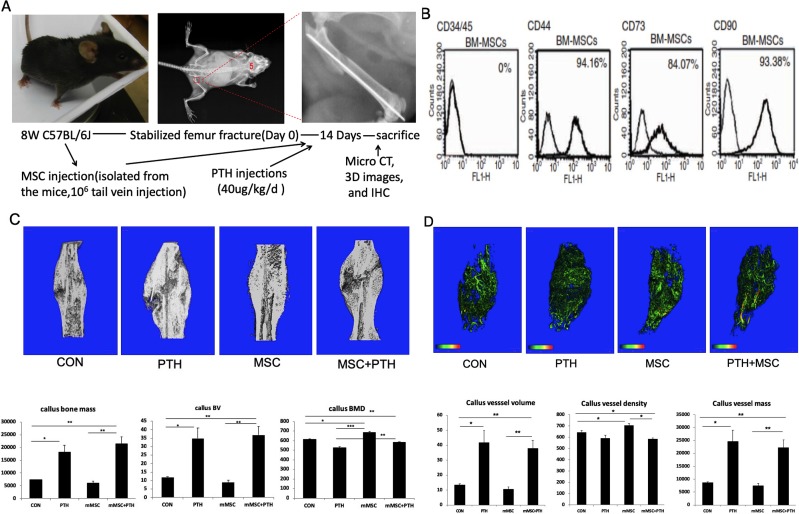
Experimental design and model establishment.(A) Stabilized femur fractures were produced in 6-week-old C57BL/6 female mice. Mice were divided into 4 groups: The control group was treated by subcutaneous injection of the vehicle (BSA) daily; the PTH group was treated with subcutaneous injection of 40 μg/kg/day of PTH (1–34); the PTH+MSC group and the MSC group were treated by injecting BM-MSCs systemically in combination with or without PTH. After 14 days of treatment, bone regeneration and neovascularization were monitored using μCT, and the samples were harvested for micro CT analysis, 3D images capture, and immunohistochemistry analysis. (B) We isolated and obtained an MSC population in which >90% of cells expressed the specific MSC markers CD90 and CD44 and 84.07% of the CD73 marker. Furthermore, after immunodepletion, the MSCs were negative for CD45 (0.9±0.5%). (C) Results from the μCT analysis and quantitative analysis of bone formation in fracture calluses was performed, and the callus bone mass, callus bone volume and callus bone mineral density were calculated. (D) The blood vessels detected by microCT were quantified in decalcified calluses. Data are presented as the mean +/− SEM (n = 12) for the groups. Student’s t test for two groups comparisons was performed; *P < 0.05, **P < 0.01, and ***P < 0.001.